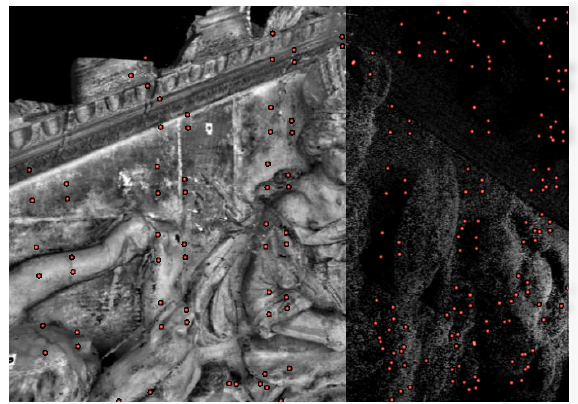
Figure 4. Camera stations (red), sparse point cloud from the SaM reconstruction (right) and point cloud derived by dense image matching (left) for a cultural heritage recording